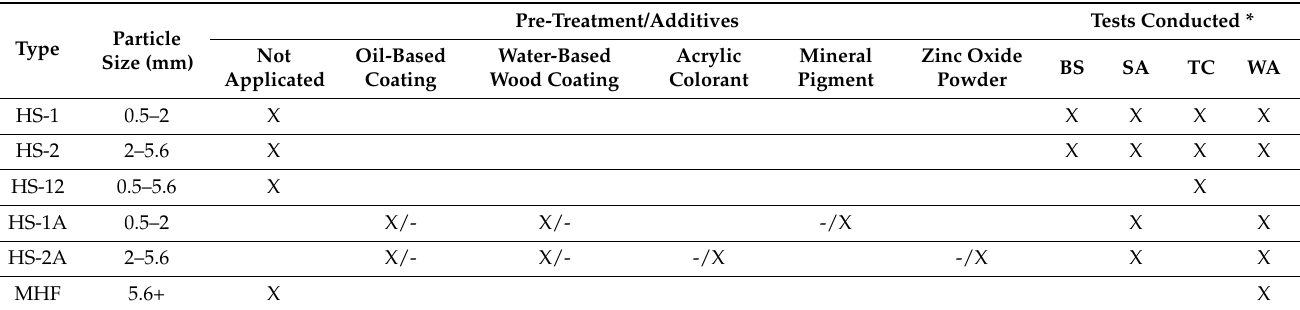
Table 1. Classification of the hemp shive boards manufactured in the